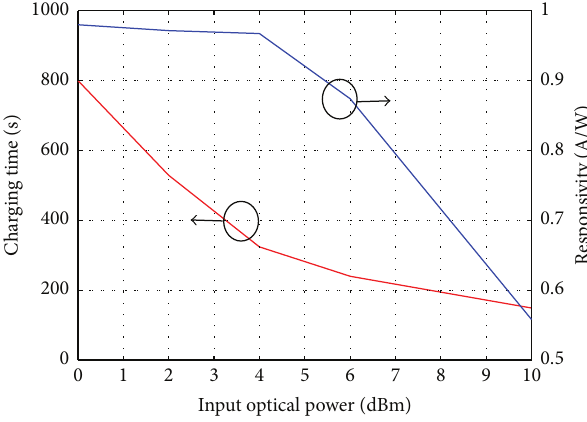
Figure 4: Trade-off between the charging time and